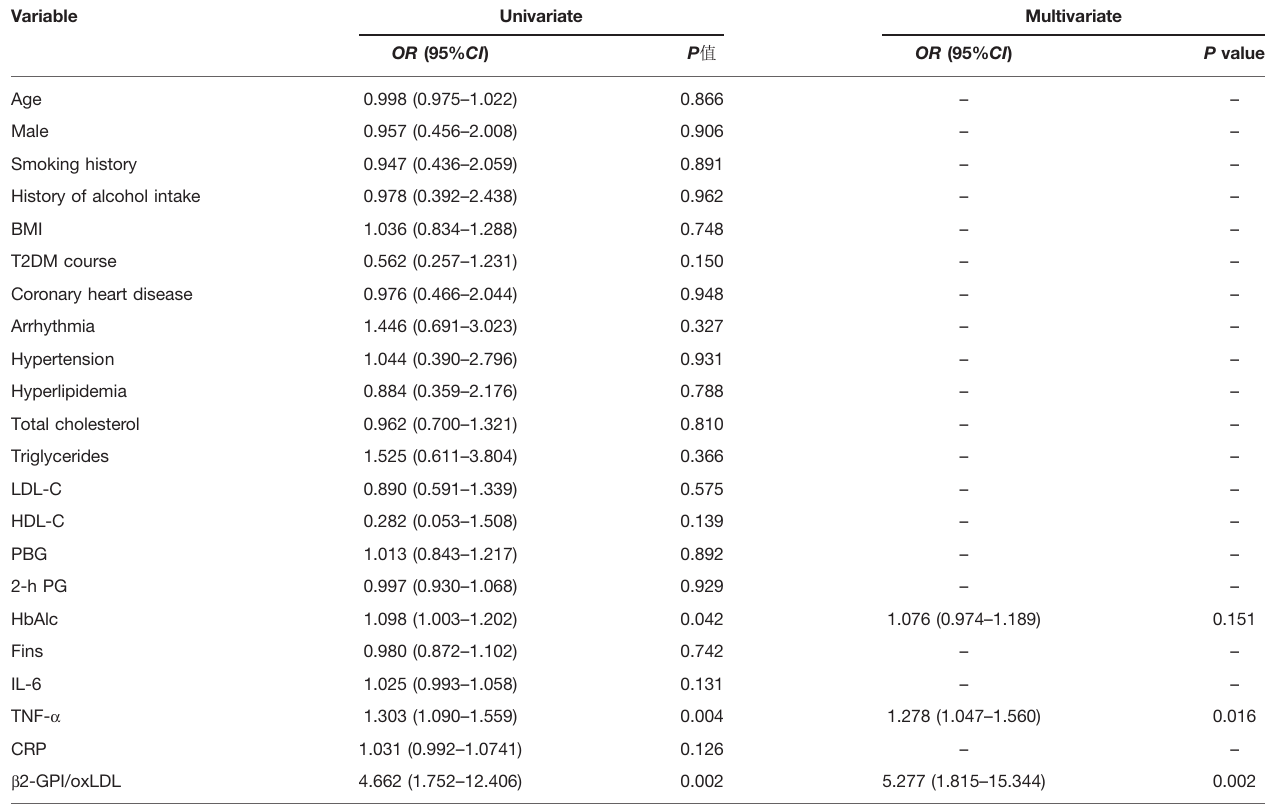
TABLE 4 | Univariate and multivariate logistic model analyses of clinical factors affecting cerebral